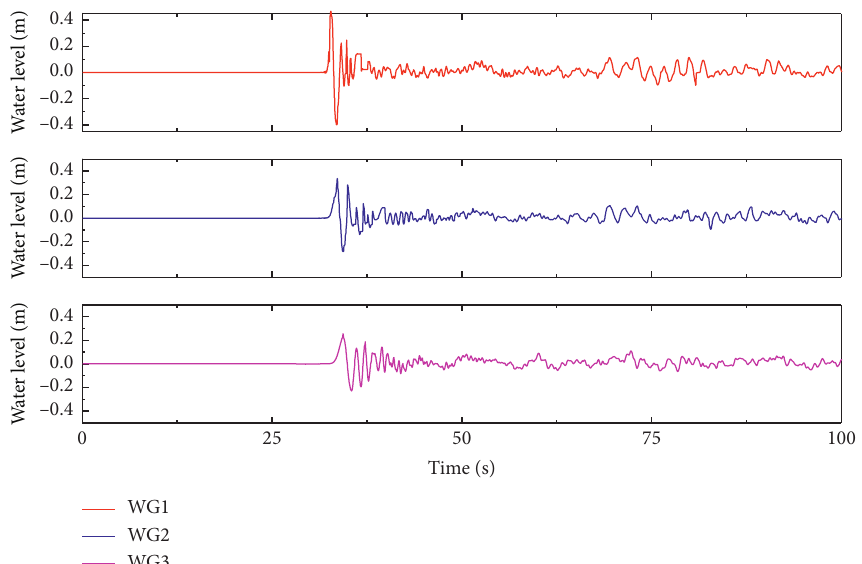
Figure 7: The water-level processes recorded by three wave gauges.